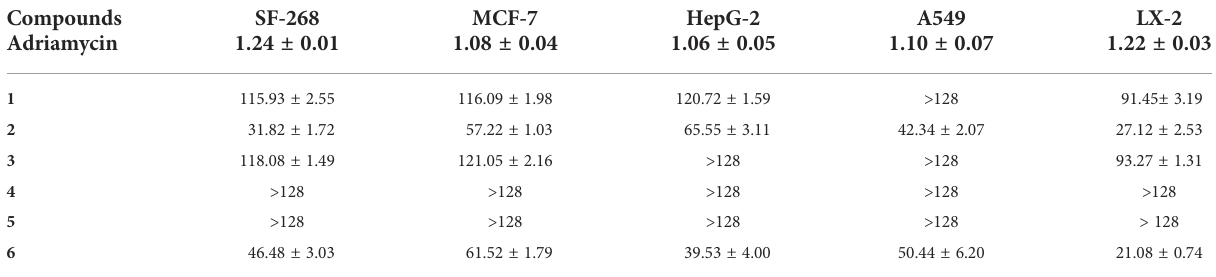
TABLE 5 Cytotoxicity activity of compounds 1 – 6 (IC 50 , m M).